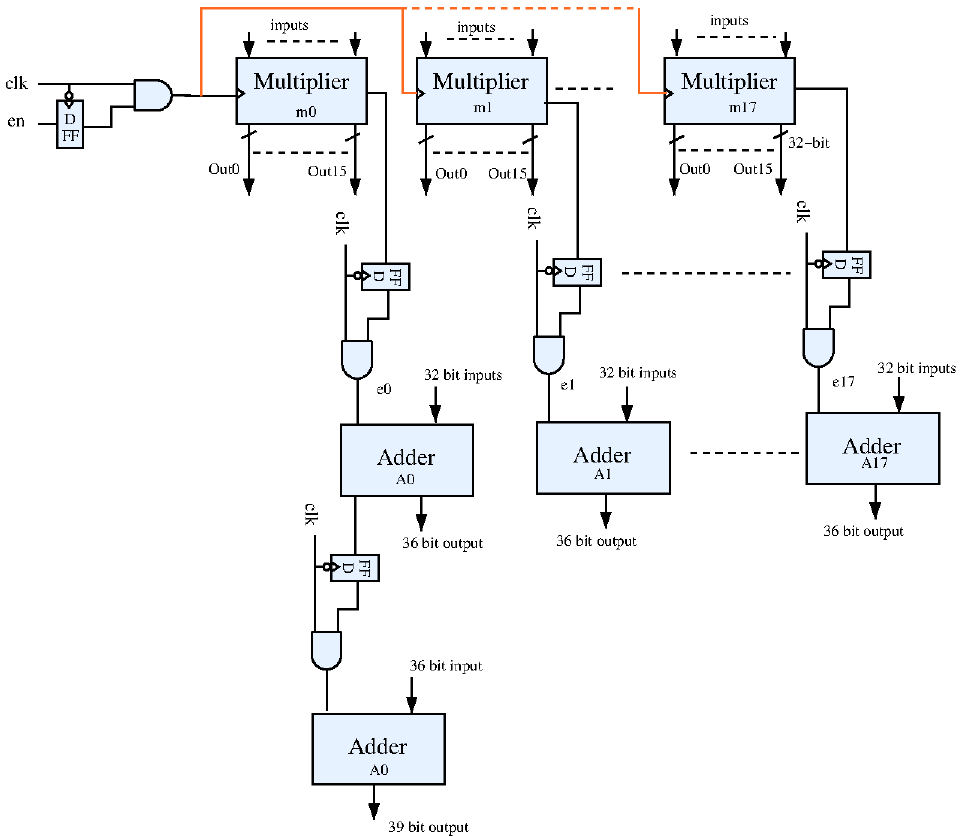
Figure 11. Overall CNN configuration with local explicit clock gating (LECG)